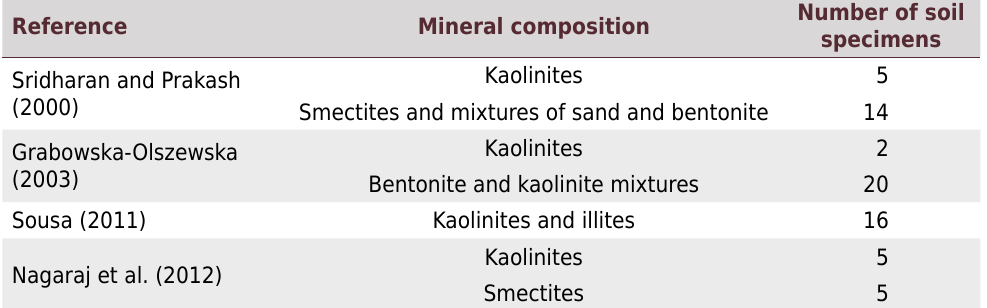
Table 2. Summary of publications, mineral composition, and number of Specimens (n) of the soils investigated in group B-02 (LL p and LL c-soft base ) with a total of 67 tested soil